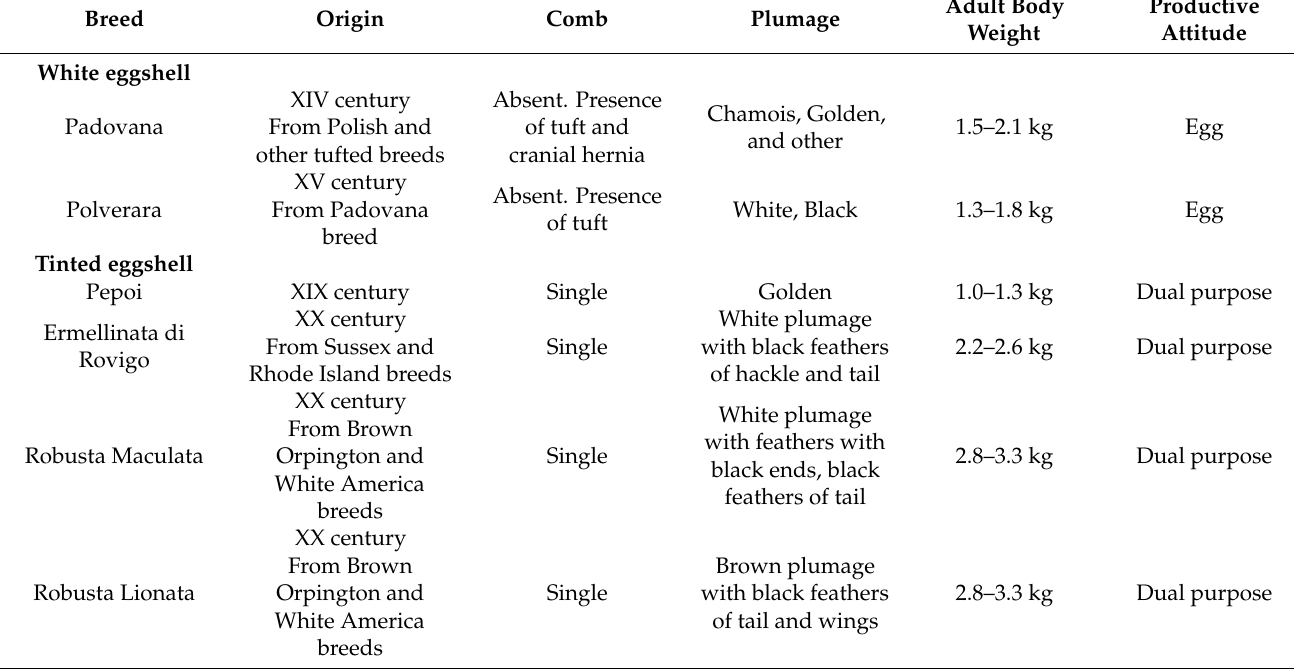
Table 1. Origin and main characteristics of hens of local chicken breeds